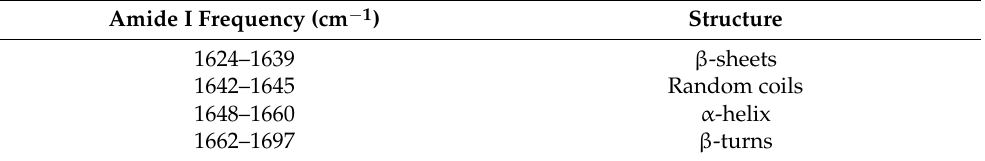
Table 2. Assignment of secondary structure based on Amide I frequency range